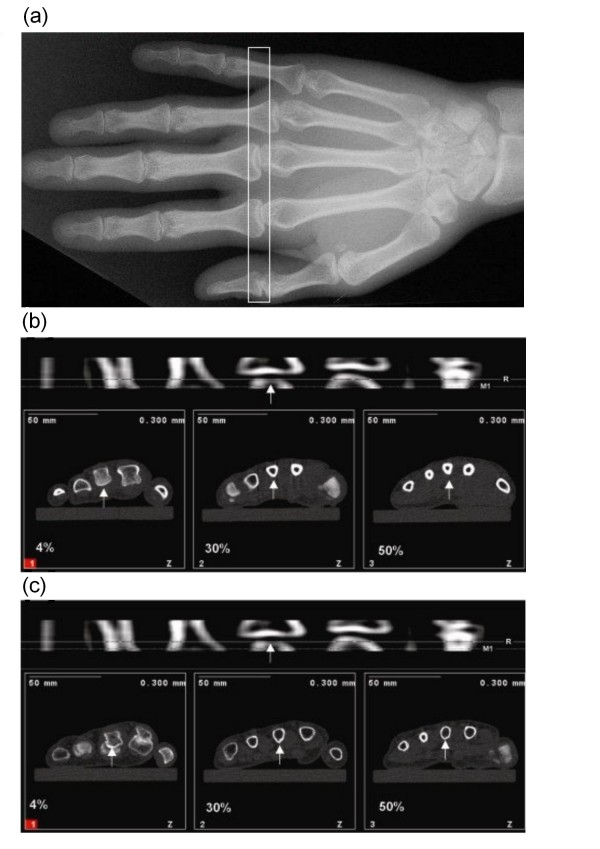
Placement of scout view (a) and typical scout view with reference line placement and the 3 metacarpal scans in a healthy reference par-ticipant (b) and RA patient (c). The third metacarpal bone is indicated with a white arrow.